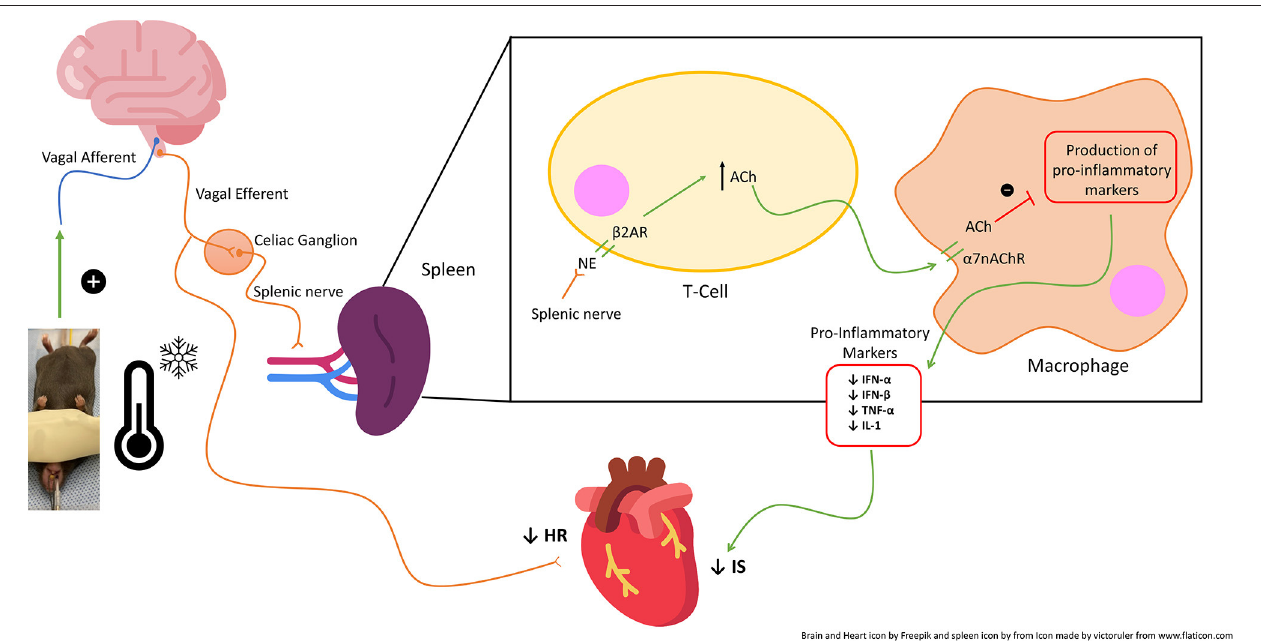
FIGURE 9 | Schematic of the proposed vagal-mediated cholinergic anti-inflammatory pathway (CAP) and mechanism of action of topical neck cooling. Neck cooling activates the vagal nerve which acts via the spleen and peripheral immune system to increase acetylcholine and thus inhibit macrophage production of splenic and peripheral pro-inflammatory markers, thus reducing infarct size (IS). NE, norepinephrine; Ach,